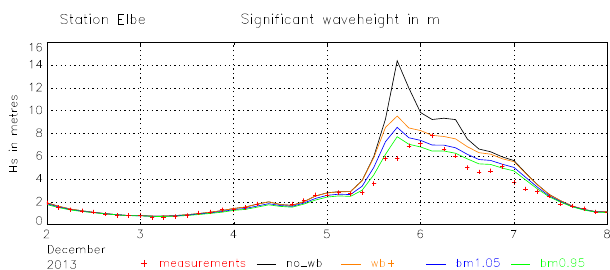
Figure 5. Time series of significant wave heights at the Elbe sta- tion (see Fig. 1 for its position) during storm Xavier (no_wb: run without wave breaking; wb + : run with a new formulation for wave breaking; bm1.05: run with a changed constant Betamax = 1.05 in the wave growth parametrization (default = 1.2); bm0.95: run with Betamax = 0.95; the last two runs include wave